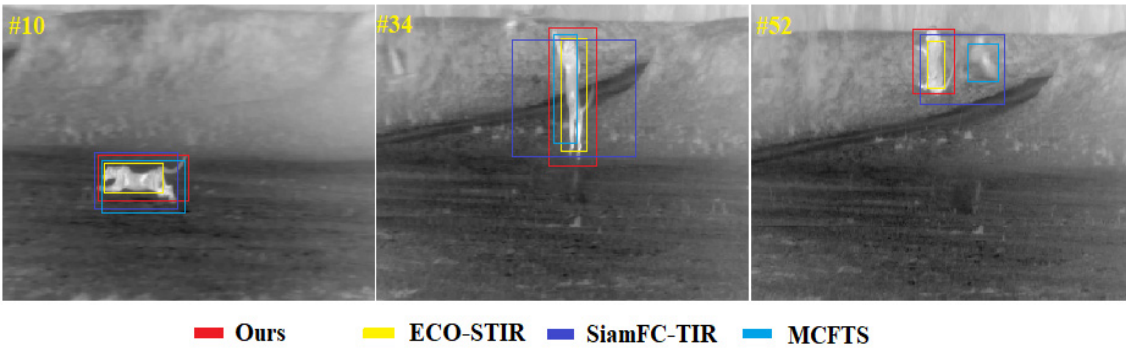
Figure 17. The visualization of tracking results in the sequence leopard_H_001.